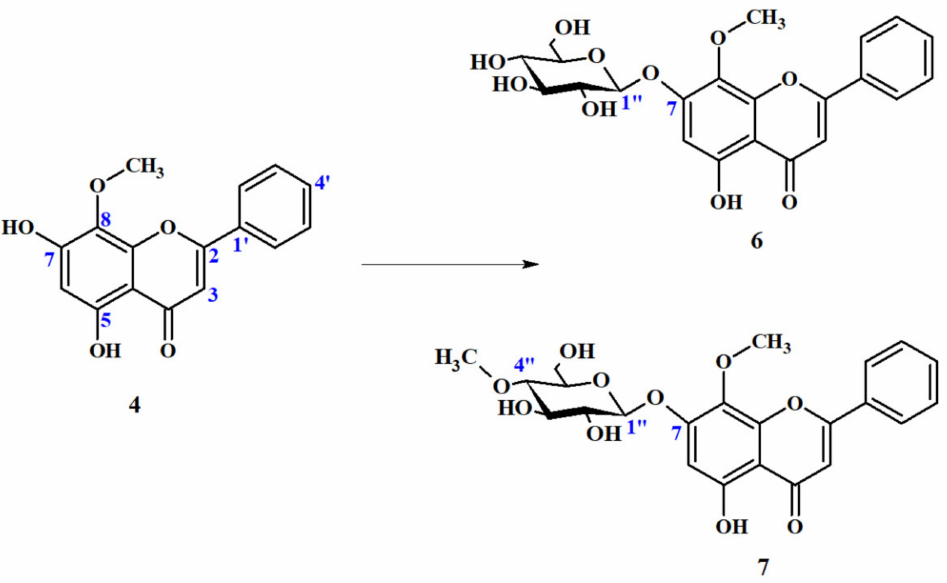
Figure 8. Biotransformation of wogonin ( 4 ) by Beuaveria bassiana